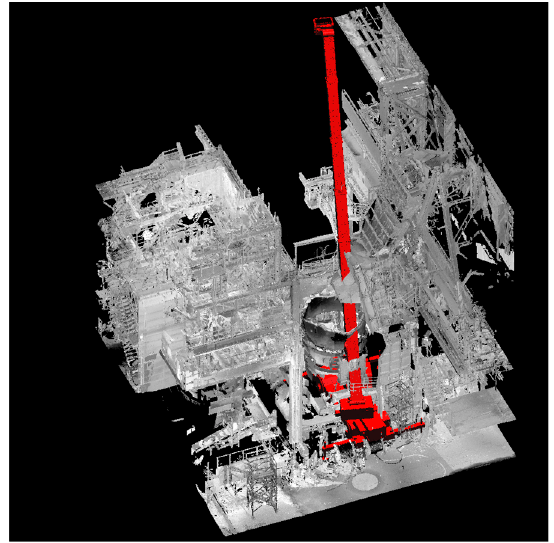
Figure 17. Point cloud of the crane vehicle (9.9 × 10 5 points) that is placed in the scene of Figure 12.